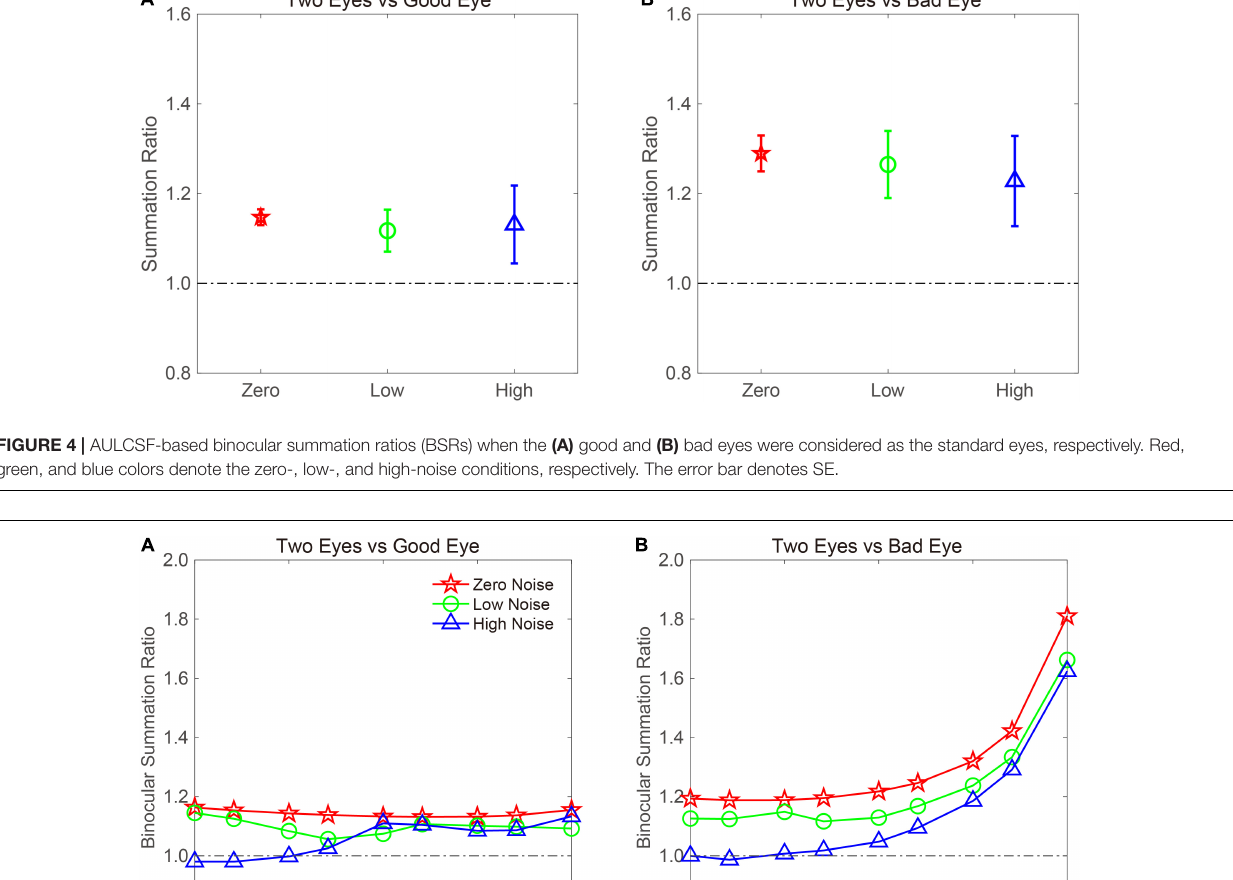
and then increased with spatial frequency. Under zero-noise conditions, the BSRs were 1.191 ± 0.002 and 1.403 ± 0.108 at low ( < 2 cpd) and high ( ≥ 2 cpd) spatial frequencies,